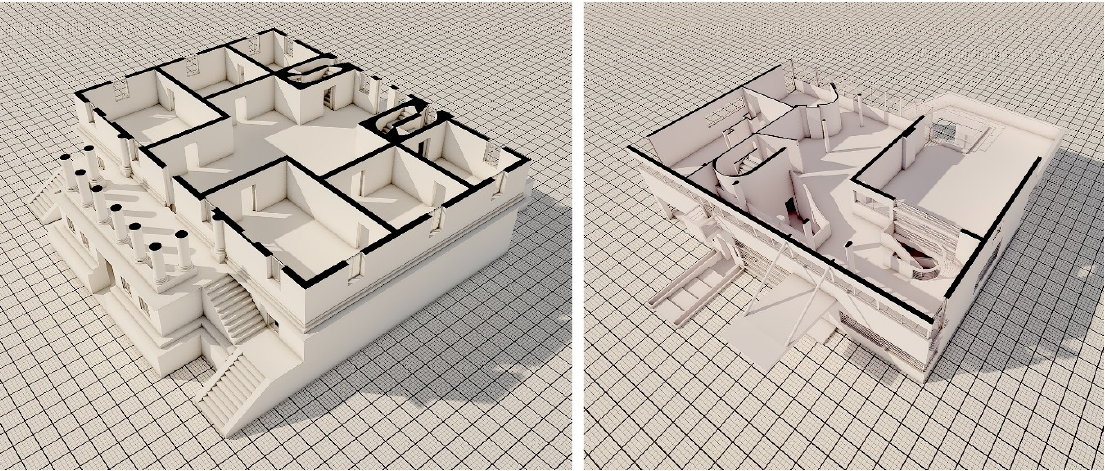
Figure 3. Cutaway plan views of Palladio’s Villa Malcontenta ( left ) and Le Corbusier’s Villa Stein ( right ).